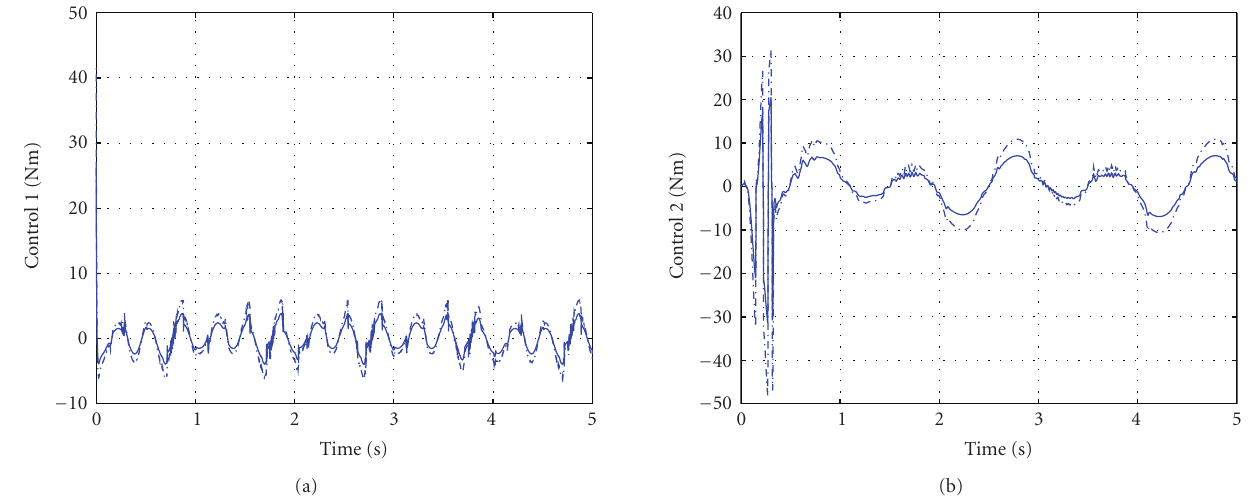
Figure 8: Comparative plots for control inputs of both joints between the controller [12] (.–) and our proposed controller